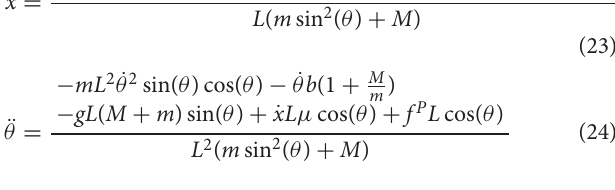
friction due to the cart movement µ , low friction linear bearings are assumed to be implemented. The friction at the pendulum pivot, b , is assumed to be